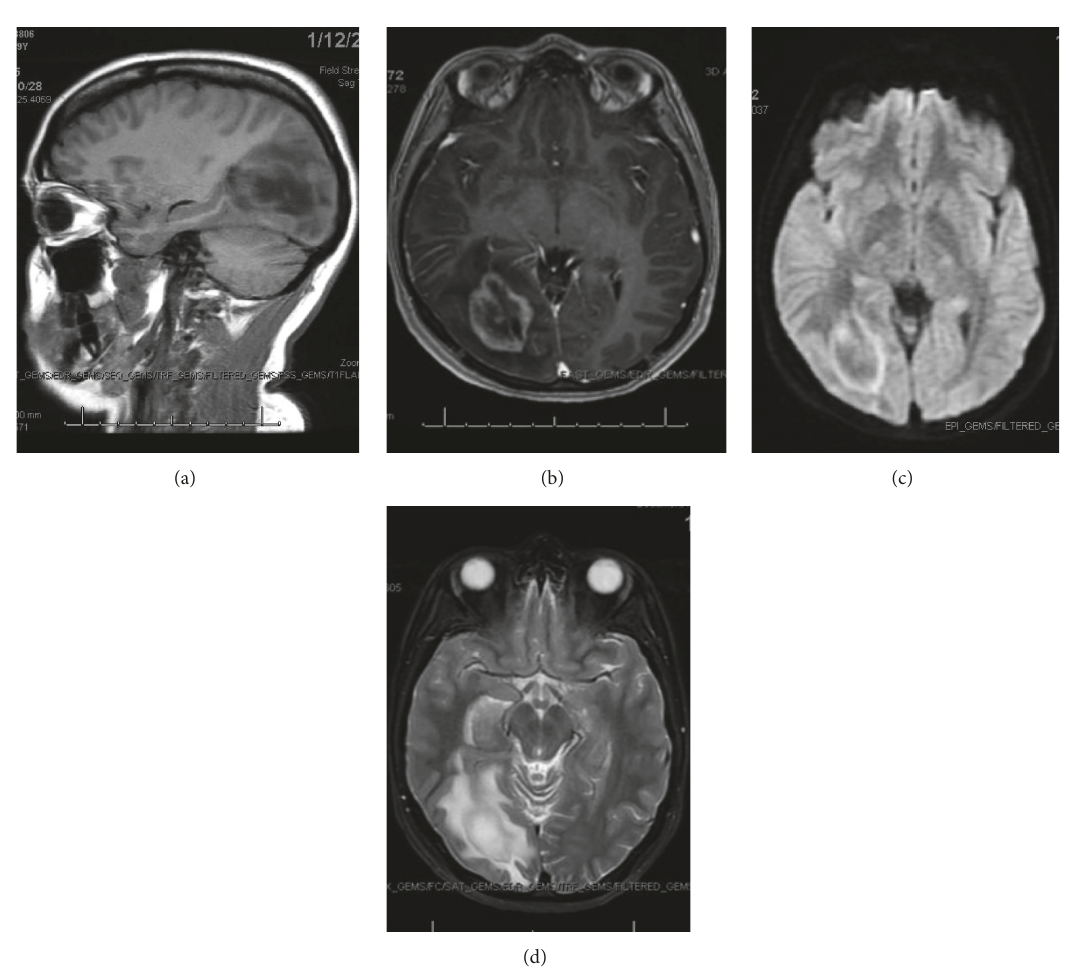
Figure 1: (a) MRI sagittal view T1 FLAIR image. (b) MRI axial T1 BRAVO image. (c) MRI axial DWI image. (d) Axial T2 FSE image. MRI Interpretation: Restricted diffusion in the right occipital lobe. There is compression of the midportion of the occipital horn of the right lateral ventricle. There is enhancement of a presumed mass surrounding the occipital horn of the right lateral ventricle with adjacent vasogenic edema. The possibility that this represents a mass of the right occipital lobe is considered. There is mass effect on the right cerebral hemisphere with effacement of the cortical